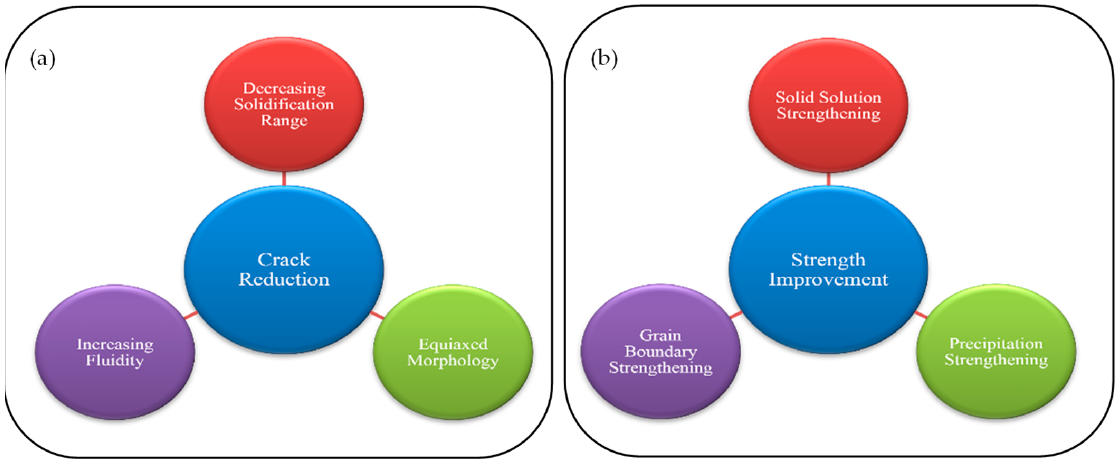
Figure 12. Benefits of modification of HS-Al alloys for AM processes: ( a ) Addressing cracking issues; ( b ) Improving strength.